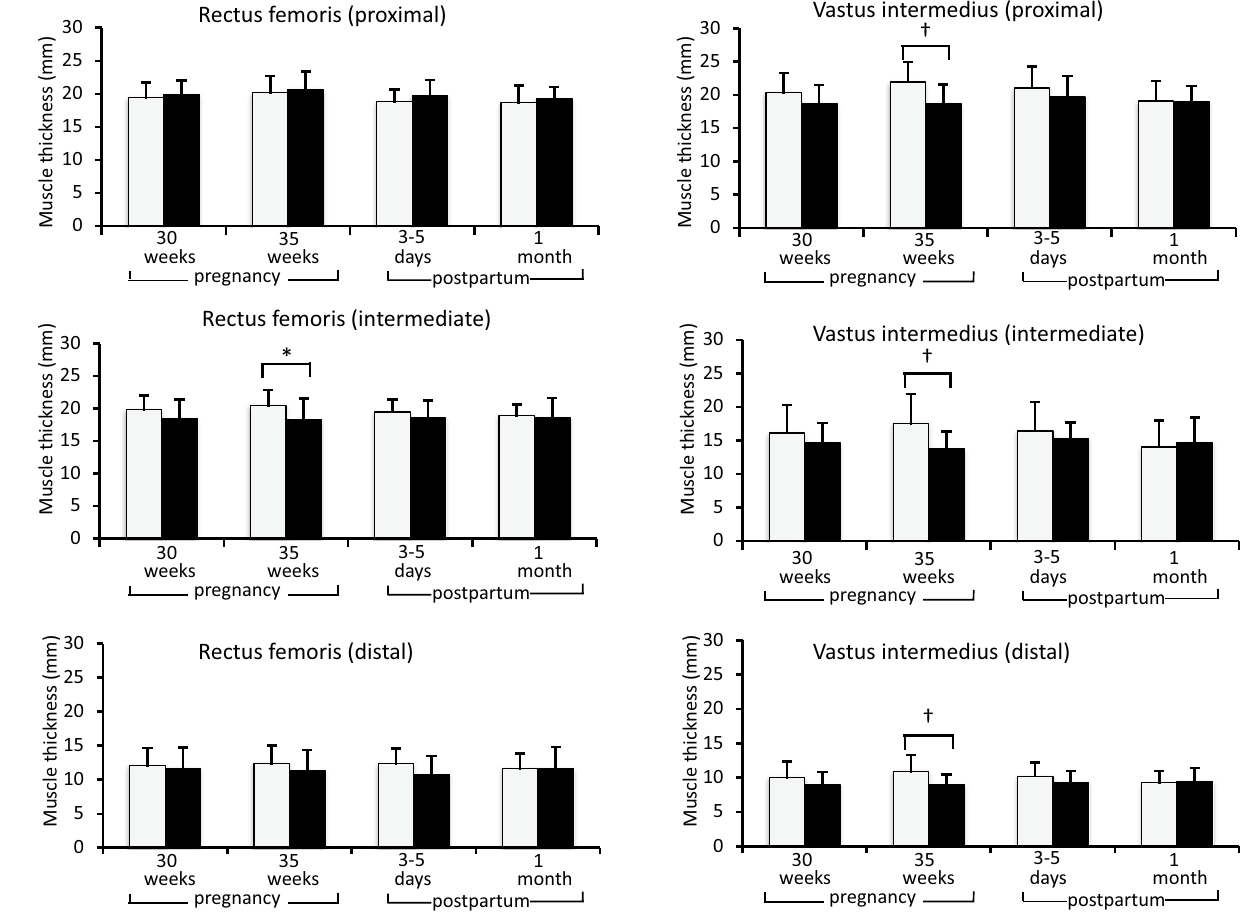
Figure 2. Comparison of muscle thickness changes between women with normal pregnancy and pregnant women on bed rest. Comparison of the changes in the muscle thickness of the rectus femoris (proximal, intermediate, and distal points) and vastus intermedius (proximal, intermediate, and distal points) between women with normal pregnancy (open bars) and women on bed rest during pregnancy (closed bars). Data are presented as mean ± standard deviation (*p < 0.05; † p <